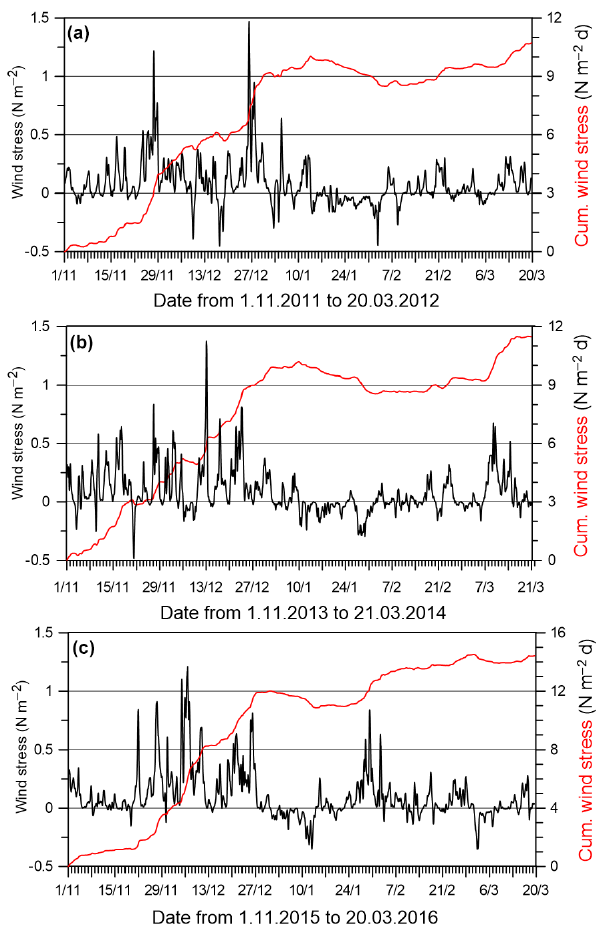
Figure 3. Time series of an along-gulf component of wind stress (black curve, positive eastward) and cumulative along-gulf wind stress (red curve), based on wind data measured at Tallinnamadal Lighthouse in the Gulf of Finland: (a) 1 November 2011 to 20 March 2012; (b) 1 November 2013 to 21 March 2014; (c) 1 Novem- ber 2011 to 20 March